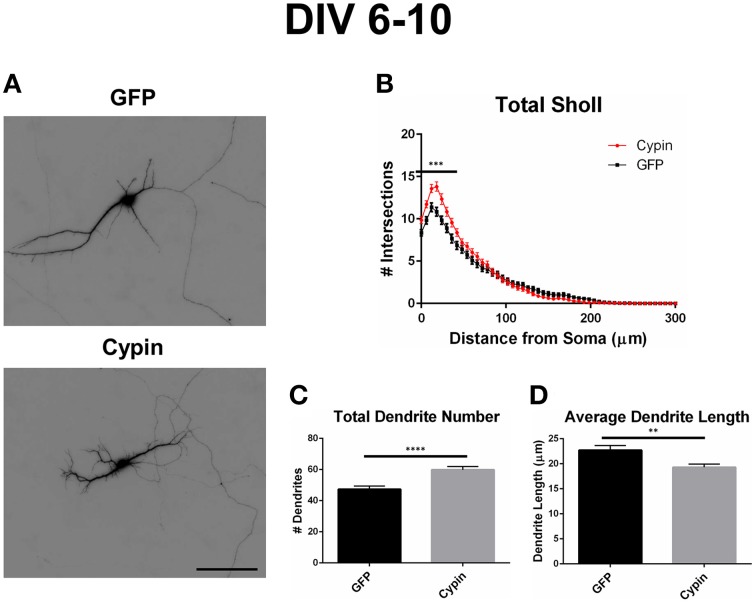
Overexpression of cypin from DIV 6–10 increases proximal branching and total dendrite number but decreases average dendrite length. (A) Representative images of hippocampal neurons overexpressing GFP or GFP-cypin (cypin) from DIV 6–10. Scale bar = 100 μm. (B) Sholl analysis of all orders of branches (Total Sholl) shows that overexpression of cypin significantly increases dendrite branching at 0–42 μm from the cell body (***p < 0.001). Statistics were calculated using Two-Way ANOVA followed by Bonferroni multiple comparisons test. (C) Overexpression of cypin results in a significant increase in the total number of dendrites (****p < 0.0001). Total number of dendrites represents sum of all dendrites, regardless to what category they belong. Statistics were calculated by unpaired, two-tailed Student's t-test. (D) Overexpression of cypin results in a significant decrease in the average length of dendrites (**p < 0.001). Average length is the mean length of all dendrites, regardless to what category they belong. Statistics were calculated by unpaired, two-tailed Student's t-test with Welch's correction. Error bars indicate SEM. n = 50 neurons for GFP, and n = 55 neurons for cypin.